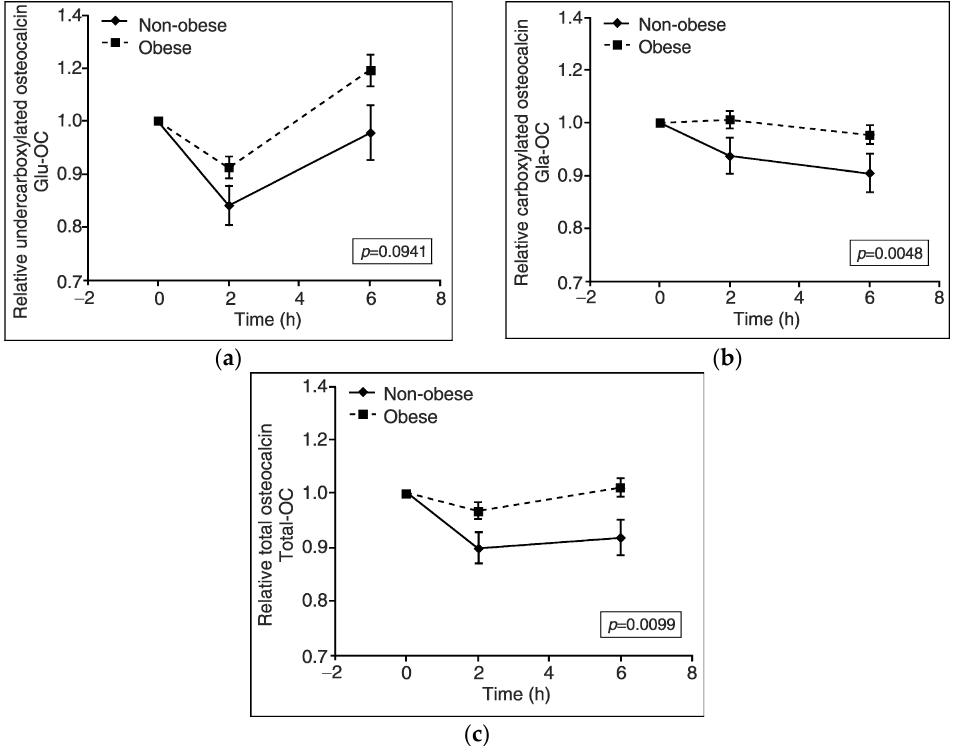
Figure 3. Relative changes in blood levels of osteocalcins during a high fat mixed meal tolerance test in obese ( n = 70) and non-obese subjects ( n = 24). ( a ) Relative undercarboxylated osteocalcin (Glu-OC) concentration in serum. ( b ) Relative carboxylated osteocalcin (Gla-OC) concentration in serum. ( c ) Relative total osteocalcin (total-OC) concentration in serum. Values are presented as means ± SEM. Statistics: The total areas under curves (AUCs) were measured by the trapezoidal method and differed between non-obese and obese subjects in Gla-OC ( p = 0.0048, unpaired t -test) and total-OC ( p = 0.0099, unpaired t -test), but not in Glu-OC ( p = 0.0941, Mann-Whitney U -test).